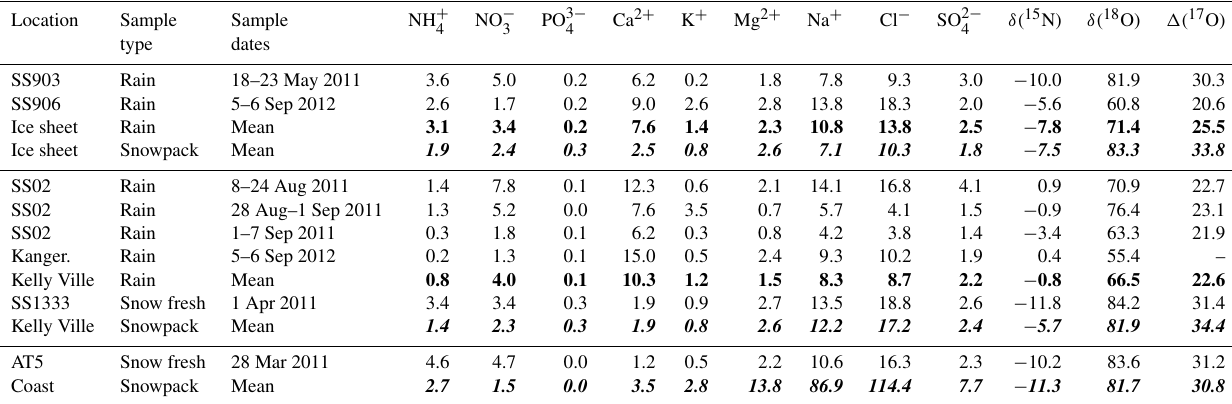
Table 5. Comparison of ad hoc rain and fresh snow samples with mean snowpack data (from Table 4; italics) (concentrations in µmolL − 1 ; isotopes in ‰). Mean data are in